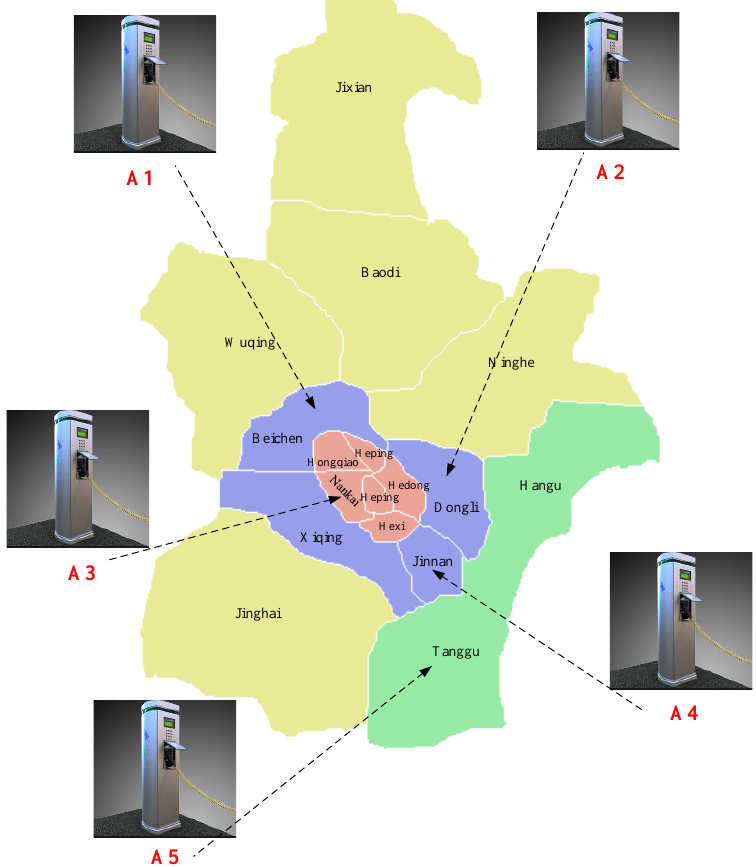
Figure 3. The geographical locations of five EVCS site alternatives Table 5. Linguistic ratings for sub-criteria performances of five EVCS site alternatives.